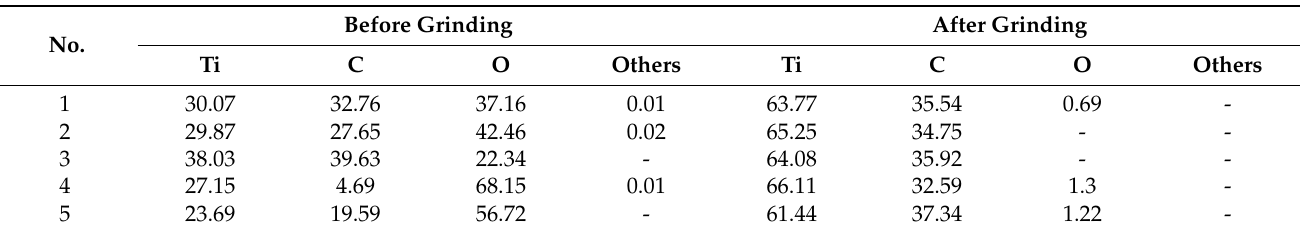
Figure 4. Typical SEM images of treated surface: ( a , b ) before grinding, ( c , d ) after grinding. The element composition determined by energy-dispersive spectroscopy at various local sections on the treated surface before and after grinding is shown in Table 1. These data corroborate the formation of the titanium carbide phase in the titanium alloy bulk under TiO 2 film. Table 1. Chemical composition at various local sections on the treated surface before and after grinding (at.